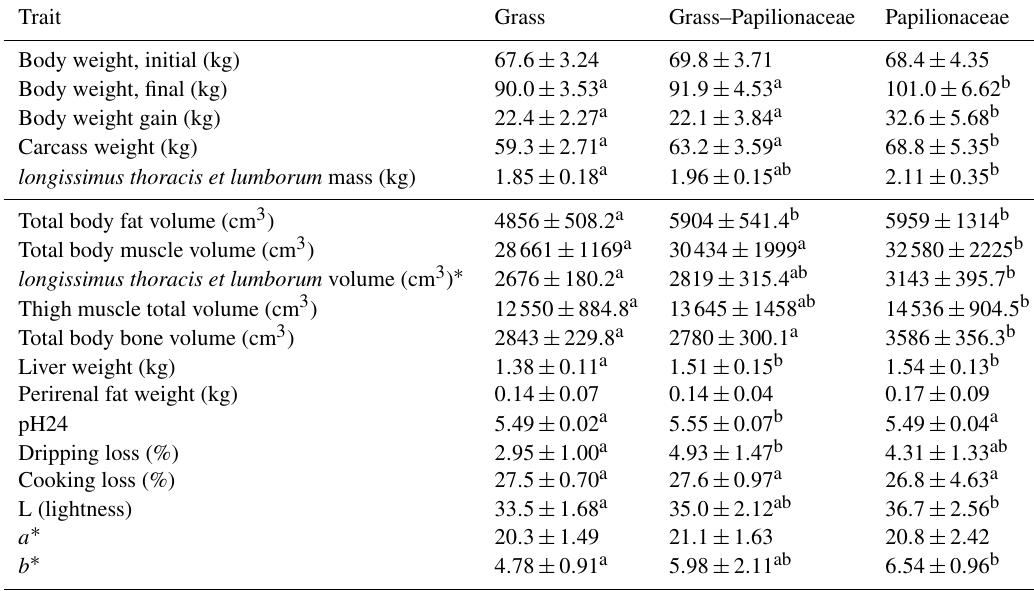
Table 3. Somatic and meat quality (LTL) traits of the deer groups. Trait